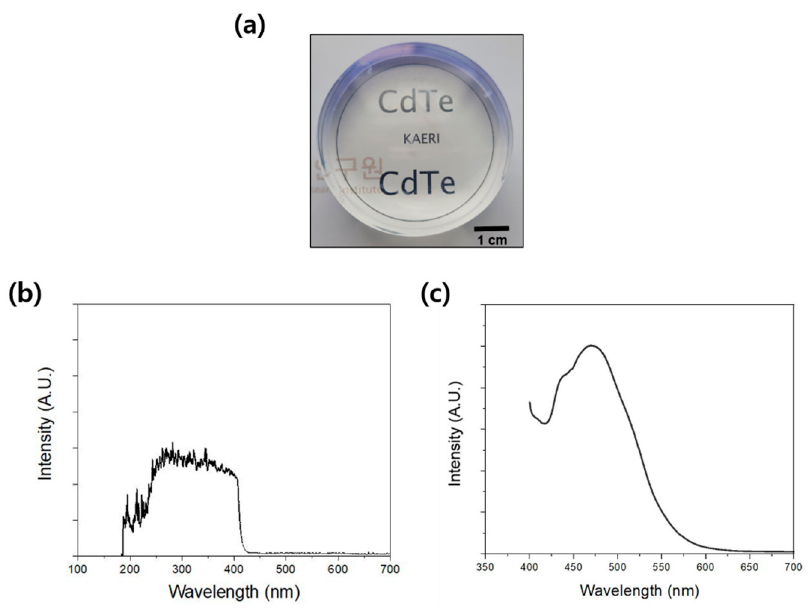
Figure 6. ( a ) A functional plastic scintillator including CdTe. ( b ) UV-Vis absorbance. ( c ) Photolumi- nescence emission spectrum, excitation at 316 nm.